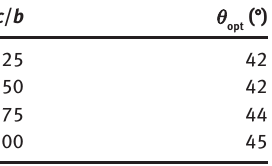
Table 3 Effect of taper ratio on the optimum fiber orientation for trapezoidal